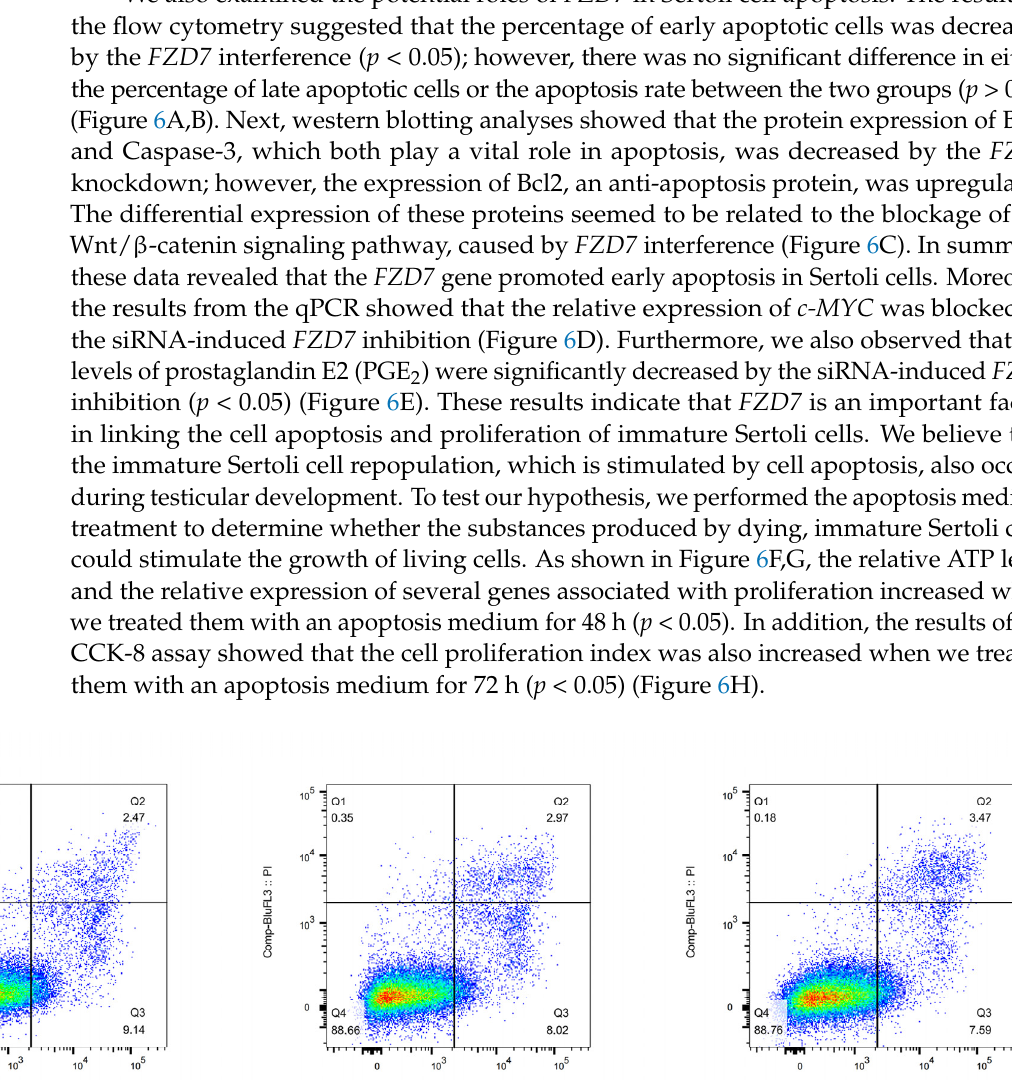
Figure 6. Sertoli cells’ repopulation by the early apoptosis. ( A , B ) Cell apoptosis phase distributions were detected using Annexin V-FITC/PI staining assay. Q1—the percentage of necrotic cells; Q2— the percentage of late apoptotic cells; Q3—the percentage of early apoptotic cells; Q4— non-apop- totic cells. ( C ) Protein expression of cell apoptosis marker genes, and those proteins were deter- mined using western blot analysis. The β -actin gene was used as the internal control. ( D ) Relative mRNA expression levels of c-MYC . ( E ) The PGE2 level was measured using a porcine PGE2 ELISA kit. ( F ) The relative ATP level for apoptosis-medium treatment. ( G ) Relative mRNA expression of the key genes of cell proliferation for apoptosis-medium treatment. ( H ) Cell proliferation index for apoptosis-medium treatment. Orange triangles and circles represented the numerical distribution